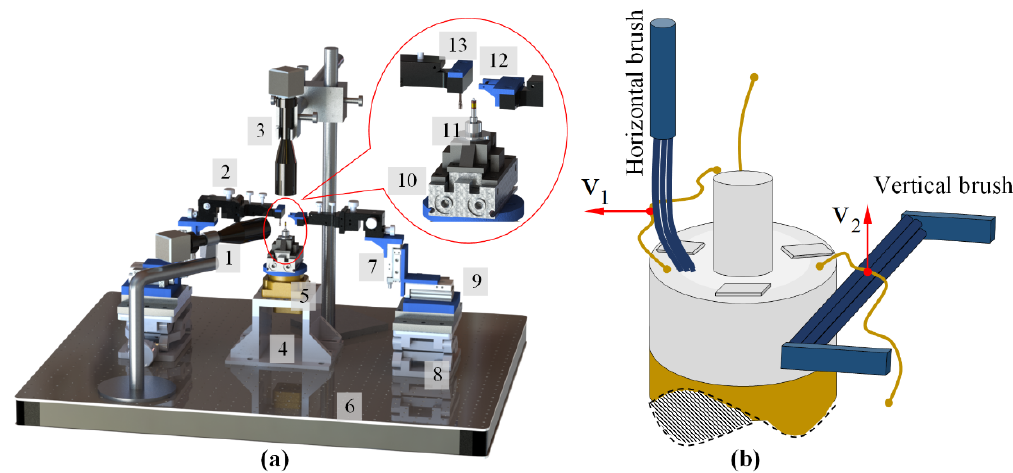
Figure 3. Setup of automated wires in the S&A brushing micro-manipulation system: ( a ) The automated system of wires used in S&A brushing micro-manipulation. ( b ) Flexible brush mechanism, with the following characteristics: 1—vision system A, 2—adjustment mechanism with four degrees of freedom, 3—vision system B, 4—support base, 5—rotating stage, 6—optical platform, 7—slide cylinder A, 8—vertical lifting platform, 9—slide cylinder B, 10—finger cylinder, 11—welding clamp, 12—vertical brushing micro-manipulator, 13—horizontal brushing micro-manipulator.